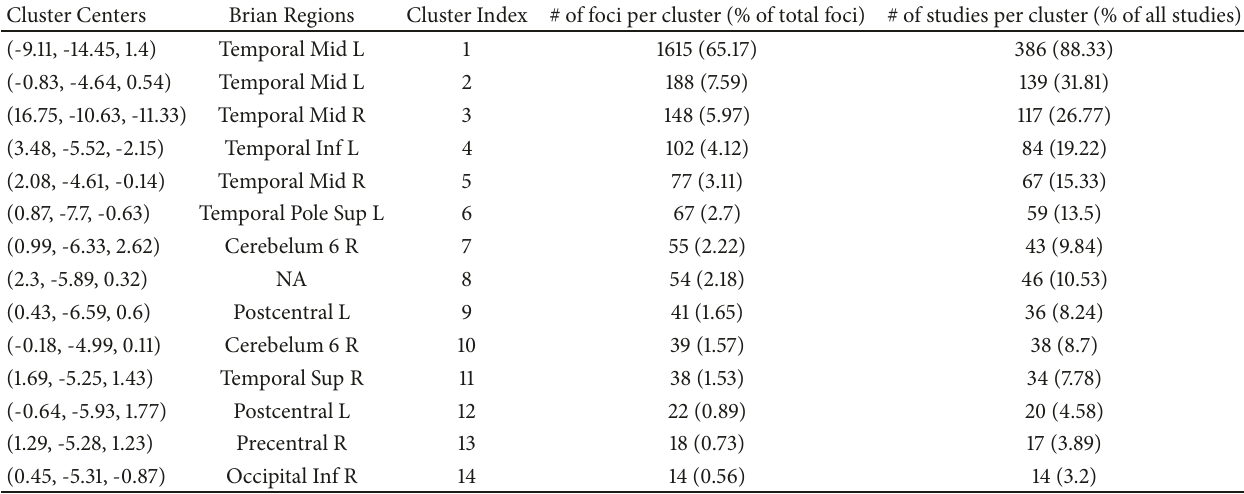
Table 6: Meta-data cluster